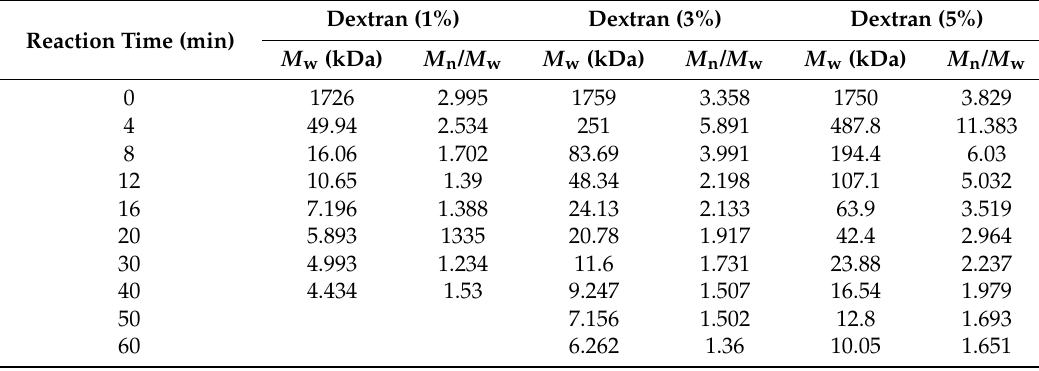
Table 7. M w and M n / M w of dextran under different substrate concentrations and time. Reaction Time